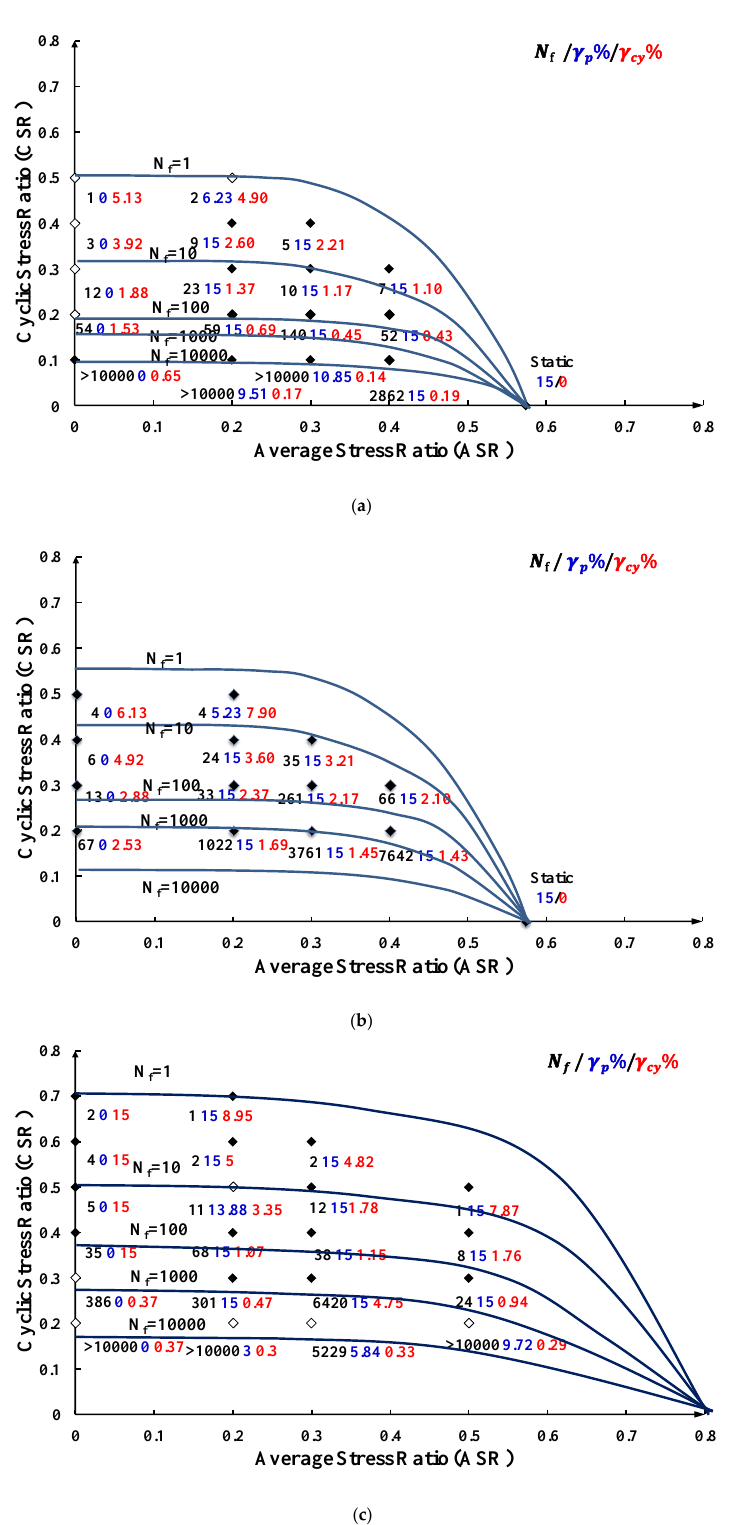
Figure 9. Design graph results: ( a ) Confining pressure 200 kPa, Relative density 50% [18]; ( b ) Confining pressure 300 kPa, Relative density 50% [21]; ( c ) Confining pressure 200 kPa, Relative density 85%.